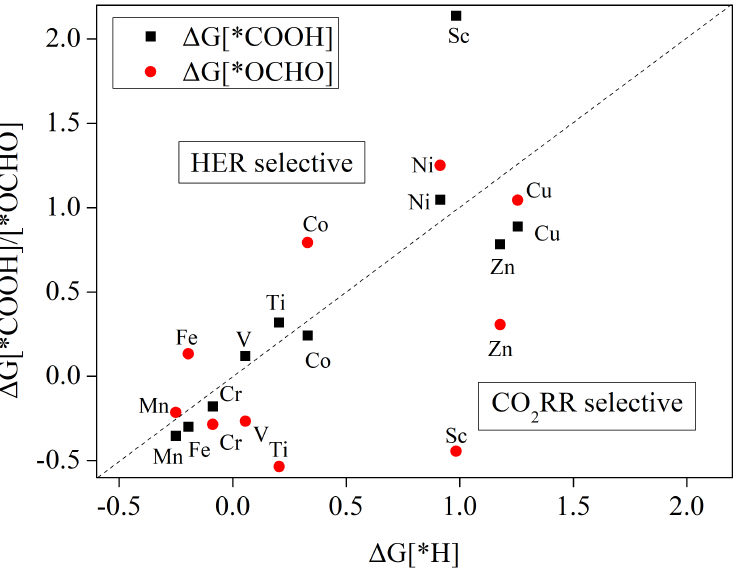
Figure 4. CO 2 RR versus HER at the first step of protonation Gibbs free energy on the TM-THQ monolayer surface. The catalyst is below the dashed line indicating good CO 2 RR